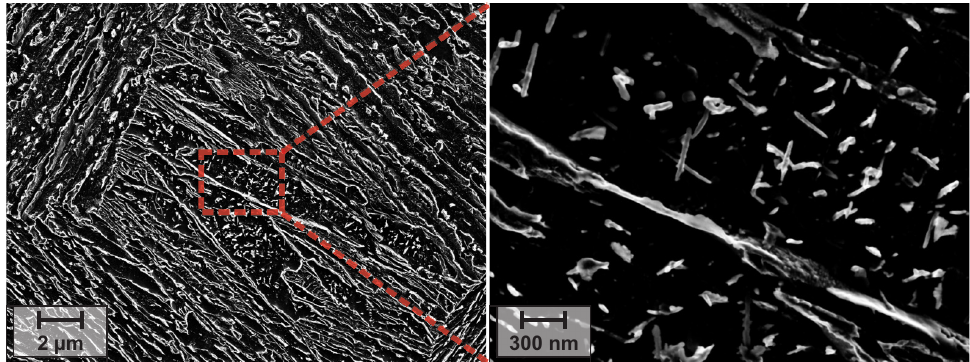
Figure 5. Carbide structures observed by SEM in the “M” steel after